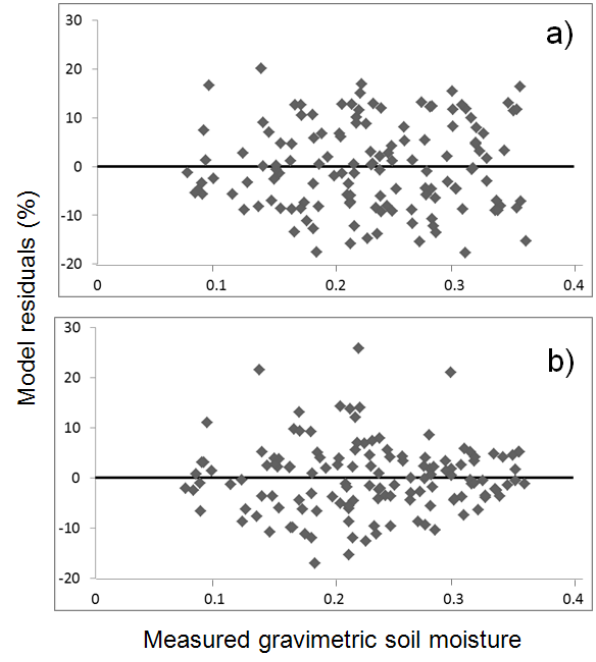
Figure 8. Plots measured gravimetric soil moisture vs. residuals of the estimation models using simulated PRISMA data with summer parameterization, both for ( a ) index and ( b ) PLSR